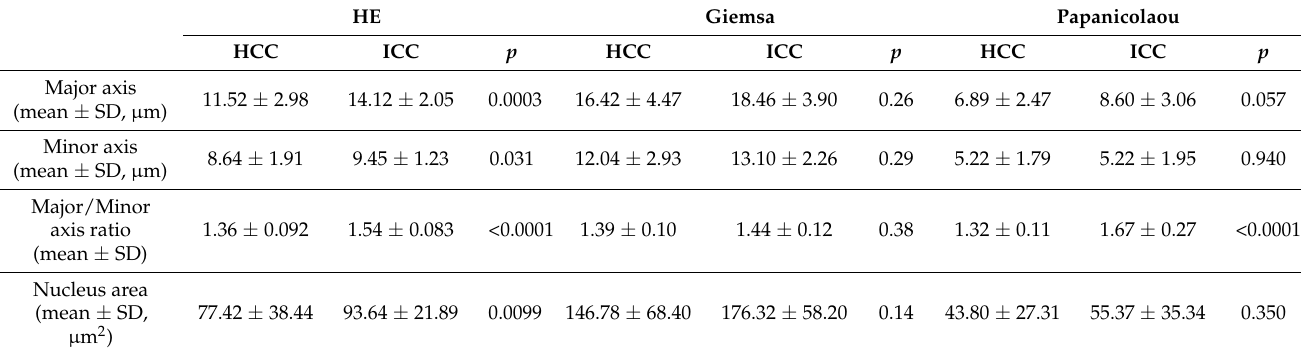
Table 2. Comparison of the Nucleus between HCC and ICC for Each